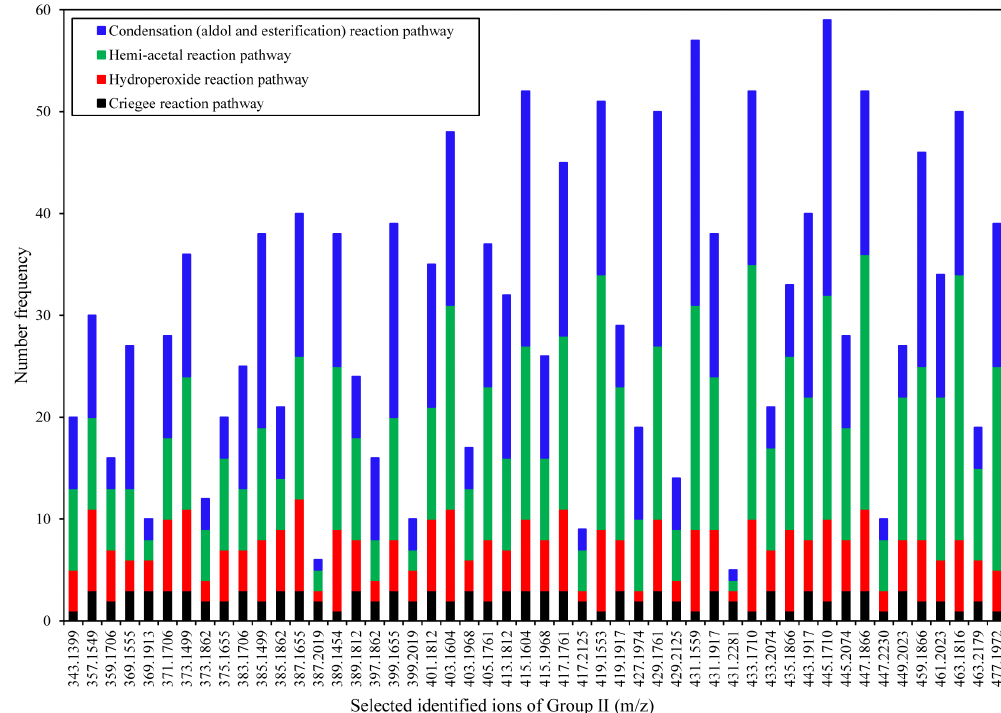
Fig. 6. Formation of the 50 most prominent Group II high MW compounds. The number frequency denotes possible combinations of building units by different reaction